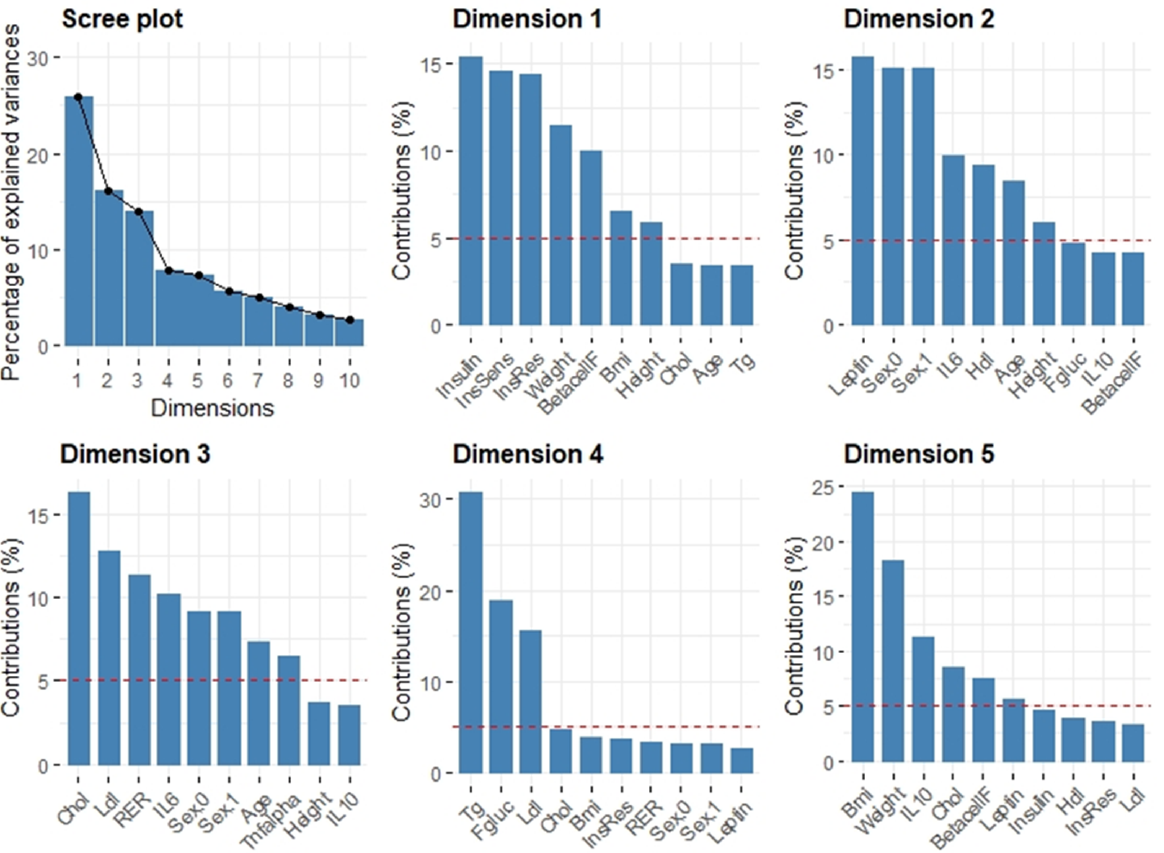
Figure 1. Output of the principal component analysis: BMI = Body Mass Index, Chol = Fasting Total Cholesterol, HDL = Fasting High Density Lipoprotein, LDL = Fasting Low Density Lipoprotein, TG = Fasting TriGlycerides, Fgluc = Fasting Glucose, BetacellF = β cell Function, InsSens = Insulin Sensitivity, InsRes = Insulin Resistance, TNFalpha = Tumor Necrosis Factor α , IL-6 = Interleukin-6, IL-10 = Interleukin-6, RER = Respiratory Exchange Ratio, Sex.0 = females, Sex.1 = males.